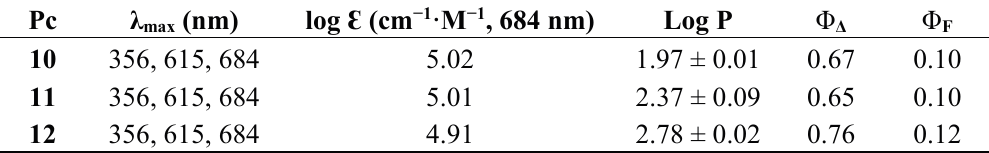
Table 1. Absorption bands, quantum yield of fluorescence ( Φ F ) and of the generation of oxygen reactive species ( Φ Δ ) for phthalocyanine synthesized (all in DMSO).